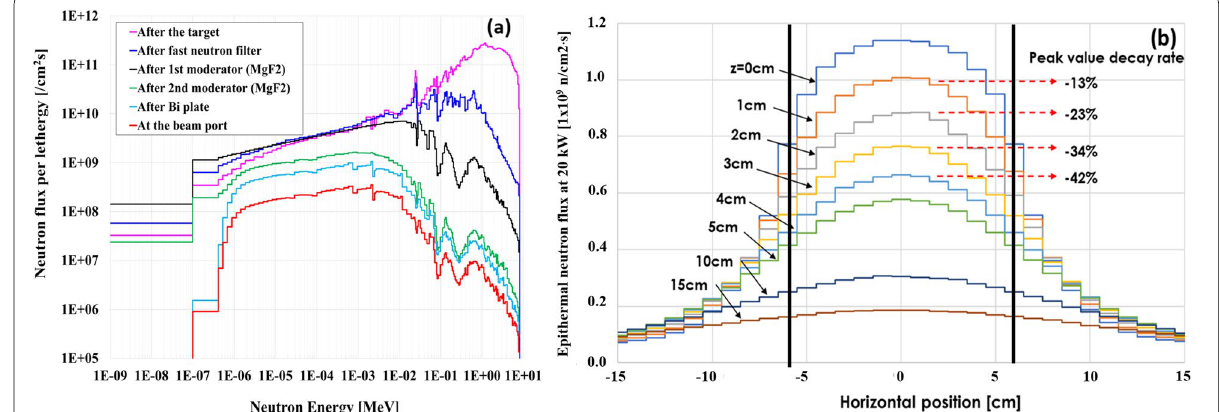
Fig. 16 a Neutron energy spectra at discrete positions from the target plate to the BSA beam port and b the lateral profile of the epithermal neutron flux from the beam exit port to a distance of 15 cm from the beam